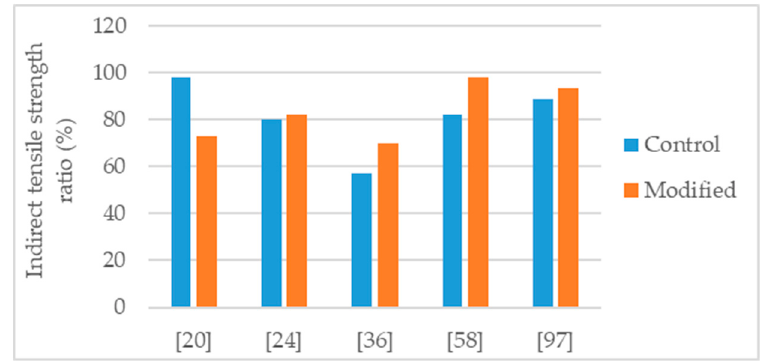
Figure 5. Indirect tensile strength ratio of control and nanosilica modified asphalt mixtures.